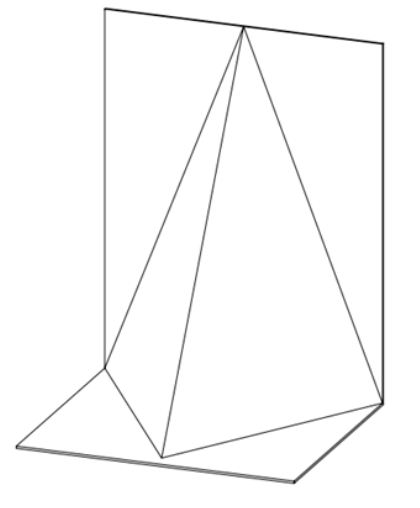
Figure 3. Combined 2D LRF and depth camera calibration board.